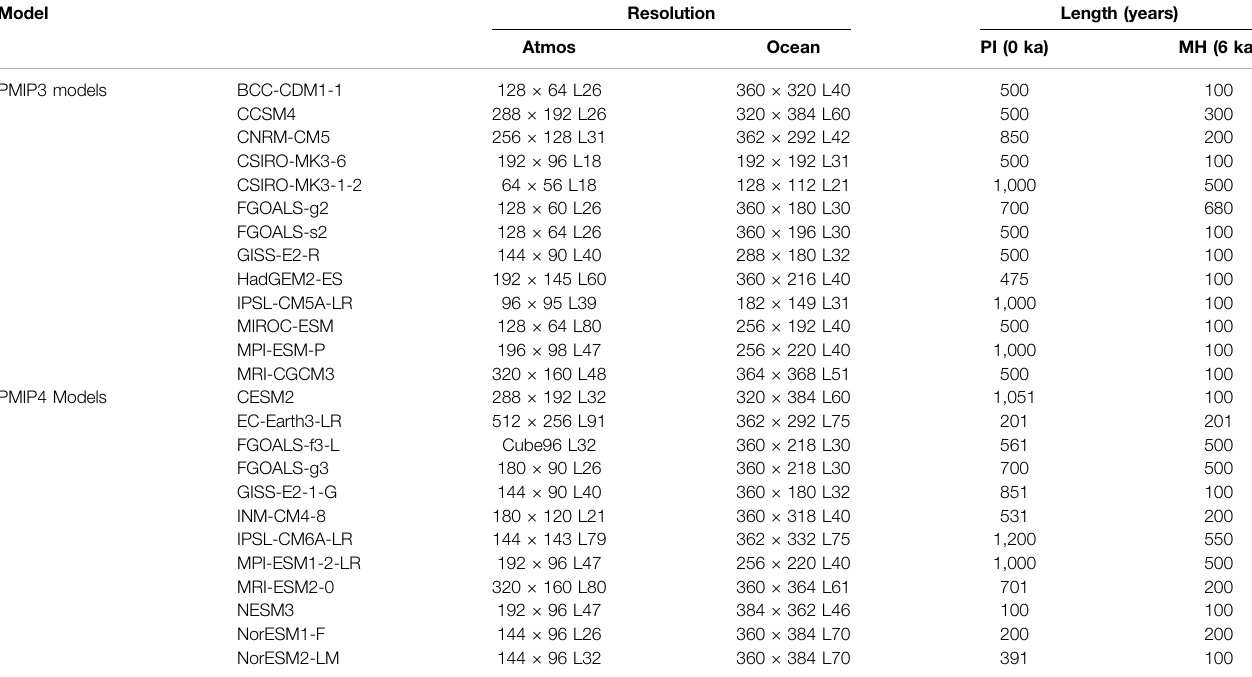
TABLE 1 | Information describing the model resolutions and simulation